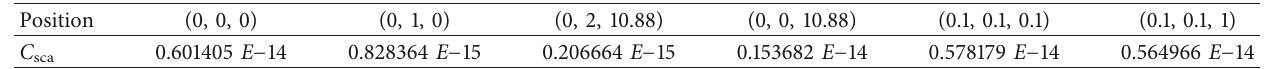
0.1, λ 0.5, m 1.33). (cid:31) (cid:31) (cid:31)